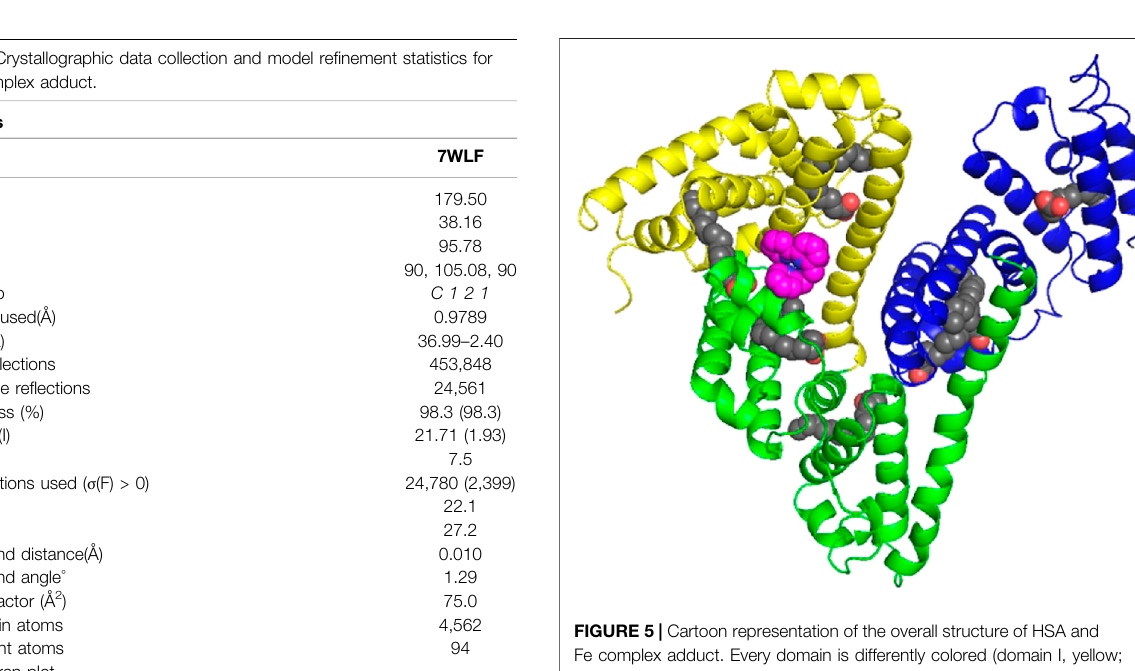
FIGURE 4 | MALDI-TOF MS spectra of HSA and HSA Fe complex adduct in DHB matrix. (A) HSA alone (black line) and (B) HSA Fe complex adduct (blue line).